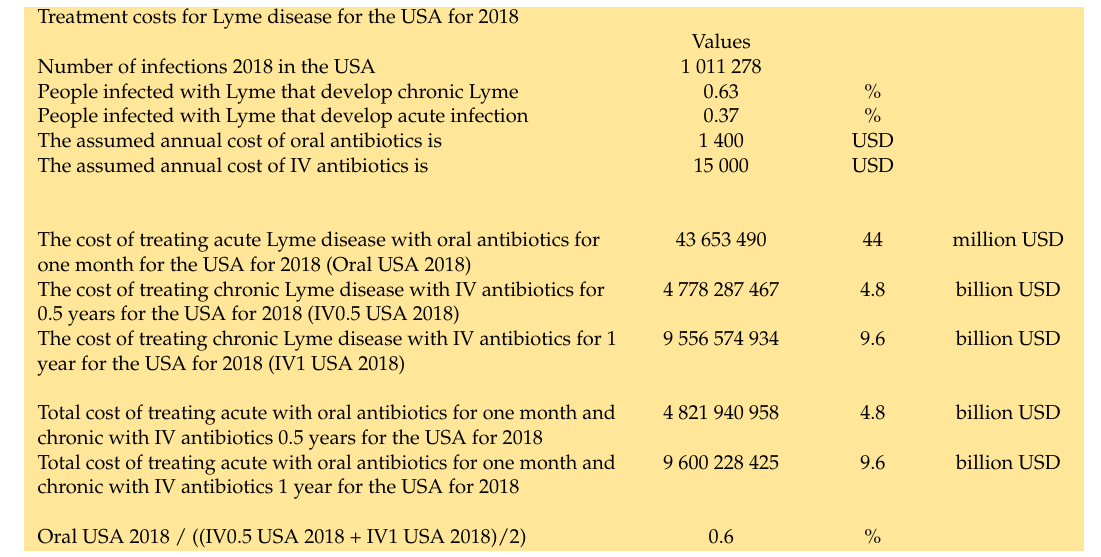
Table 11. The estimated total cost for the treatment of acute and chronic Lyme disease for the USA for